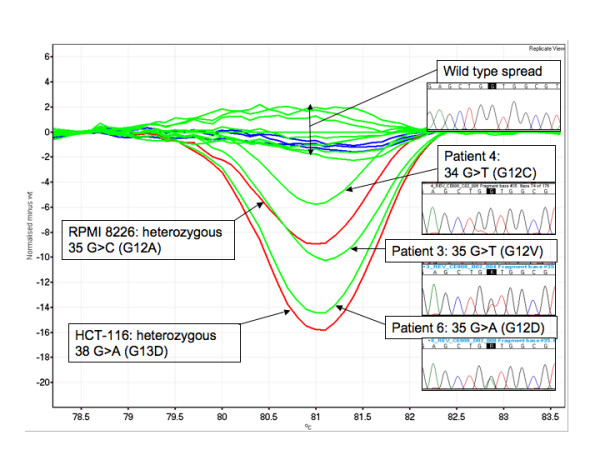
Difference plot and sequencing traces of various mutations in KRAS. Sequencing plots for each sample are below the patient numbers. The samples were compared to the median wild-type control sample to produce the difference plot. The sequencing traces for patients 3 and 6 showed the presence of a 35G > T and 35G > A mutations respectively.